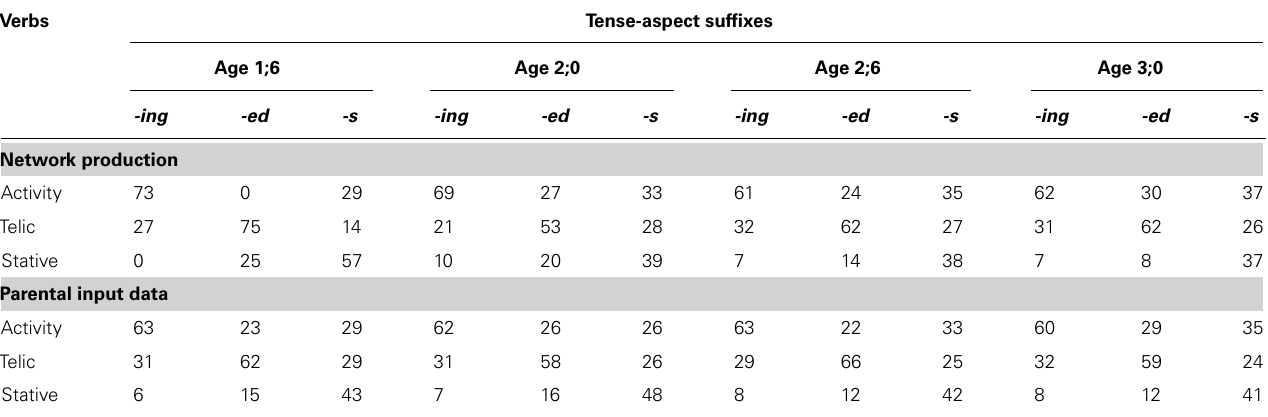
Table 2 | Percentage of use of tense-aspect suffixes with different verb types across input age groups in DevLex-II’s production and in input data based on parental speech (adapted from Li and Zhao, 2009, reproduced with permission from Mouton de Gruyter). Verbs Tense-aspect